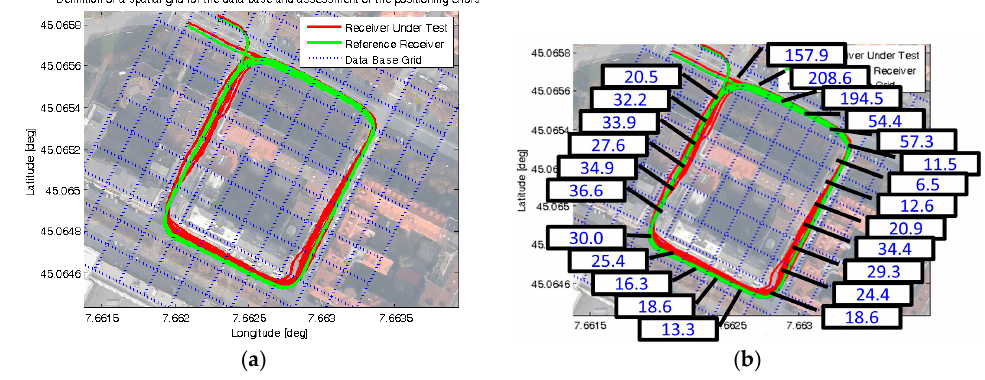
Figure 4. Results of an experimental GNSS data collection: ( a ) Positions logged and spatial grid for combining the measurements, shown in Google Maps © ; ( b ) obtained values of effective UERE, in meters.